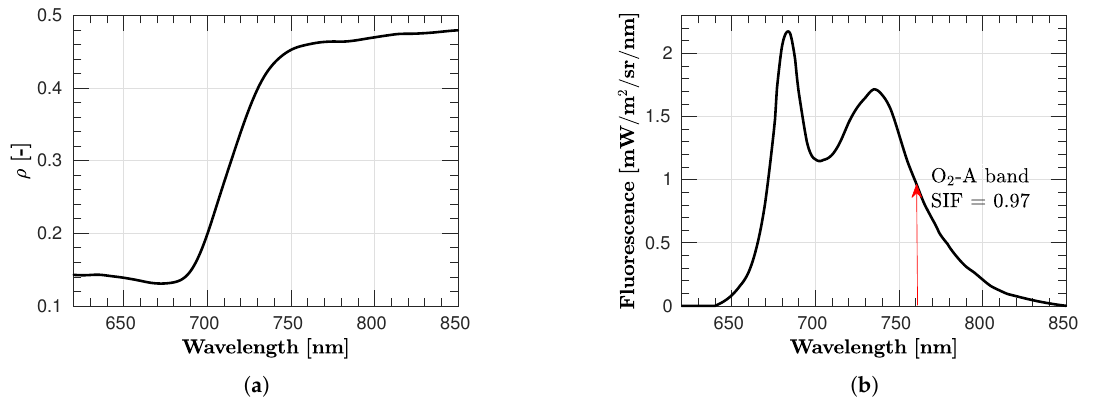
Figure A1. Surface reflectance ( a ) and fluorescence spectra( b ) used in Section 4. These spectra were originally derived from the Fluorescence EXplorer (FLEX) mission requirement document [59], where they are used as a reference dataset. The red upward arrow indicates the SIF value at the bottom of the O 2 –A absorption